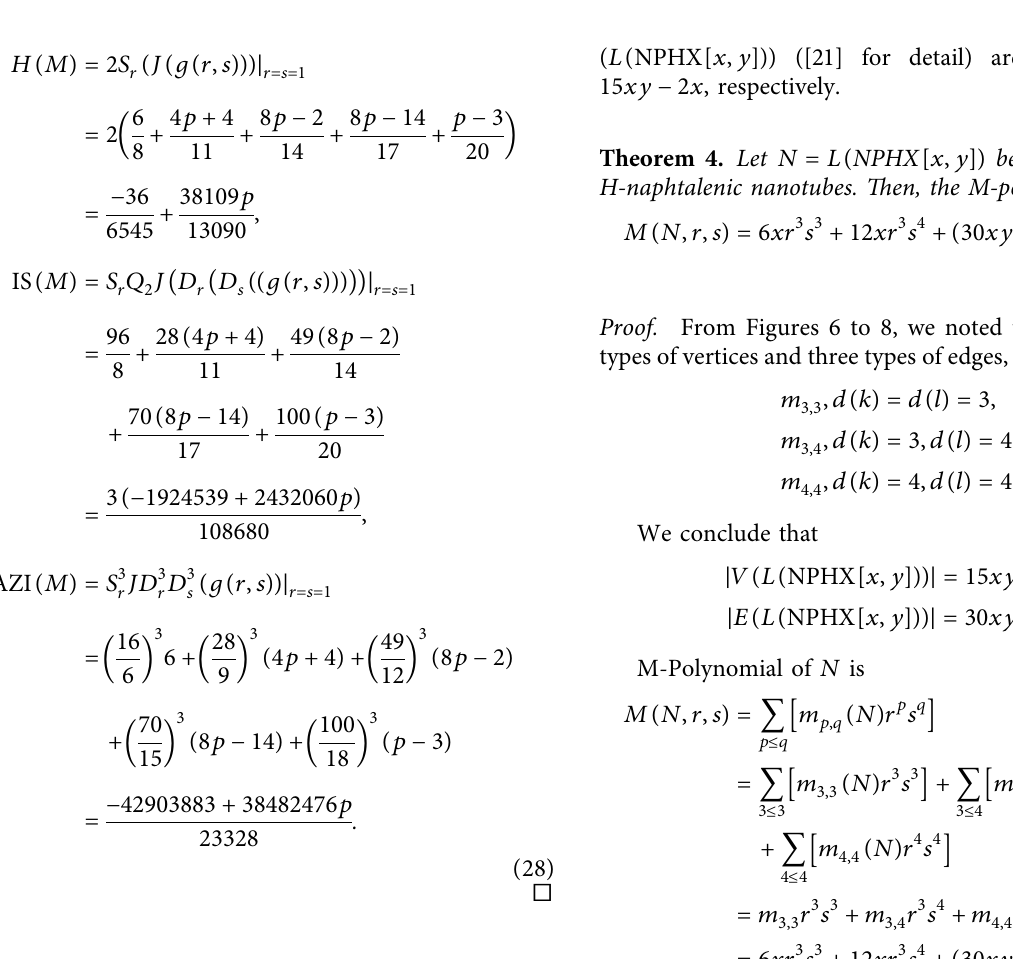
Figure 6: Graph of NPHX [ x,y ]